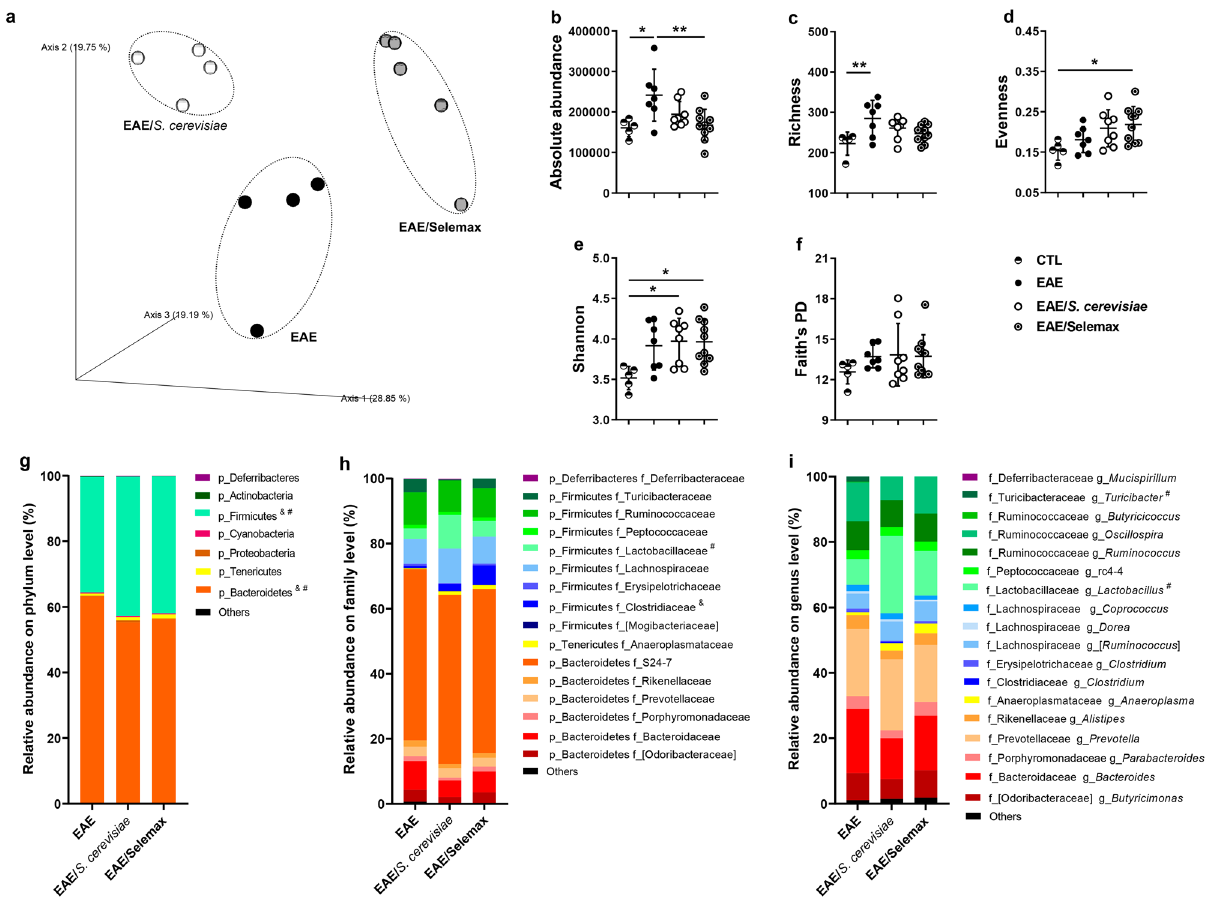
Figure 6. Effect of S. cerevisiae and Selemax on microbiota composition. EAE mice received 14 oral doses of S. cerevisiae or Selemax. Principal Coordinates Analysis (PCoA) of unweighted UniFrac distances of 16 S rRNA genes ( a ). Absolute abundance ( b ), richness ( c ), evenness ( d ), Shannon diversity index ( e ) and Faith’s phylogenetic index ( f ) of fecal bacterial OTUs. Relative abundance at phylum ( g ), family ( h ) and genus ( i ) level. Statistical analysis was performed by one-way ANOVA and subsequent Tukey’s test ( b – f ) and two-way ANOVA and subsequent Tukey’s test ( g – i ). All data were expressed as the mean ± SD and statistical differences were represented by * p < 0.05 and ** p < 0.01; # p < 0.05 between EAE and EAE/ S. cerevisiae ; & p < 0.05 between EAE view.qiime 2.org/), the graphs were created using GraphPad Prism v.8.0.2 and image was modified with Adobe Photoshop